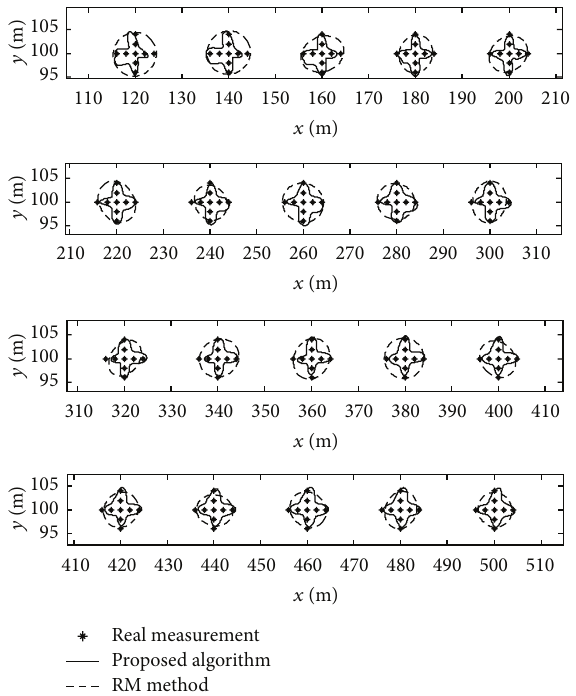
Figure 2: Shape estimation by the proposed algorithm and the RM method.